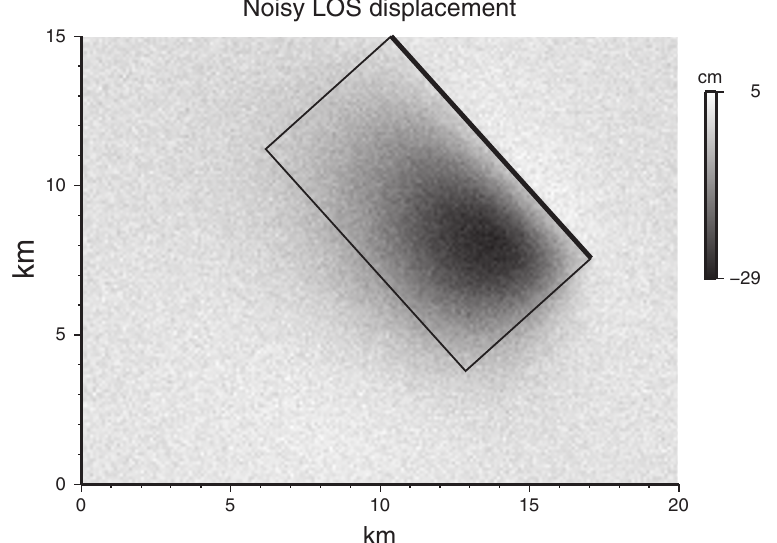
Fig. 3. Map of noisy synthetic LOS displacements generated in the LHS. Horizontal projection of the source fault in